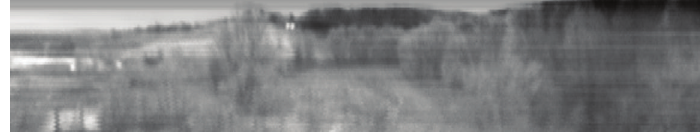
Figure 14: Image after the means subtraction.